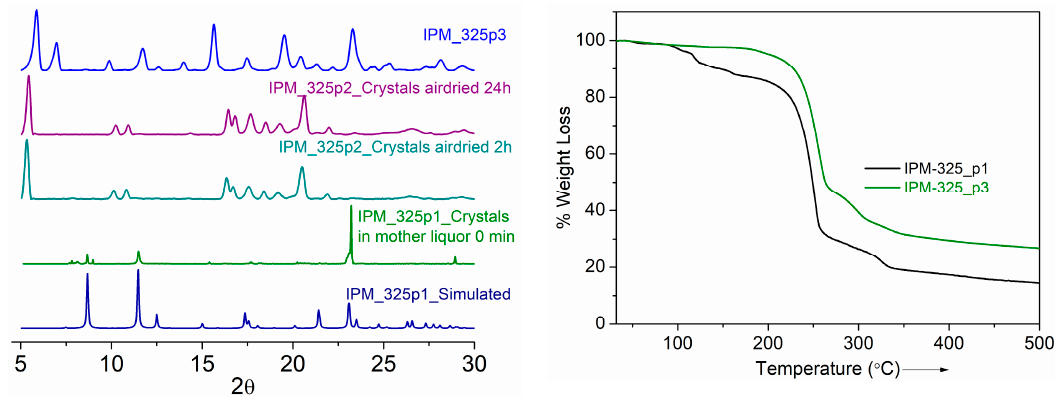
Figure 4. ( a ) Powder X-Ray diffraction patterns of simulated (IPM-325_p1) Color Code—Blue, IPM-325p1_crystals soaked in mother liquor 0 min Color Code—Green, Air exposed after 2 h